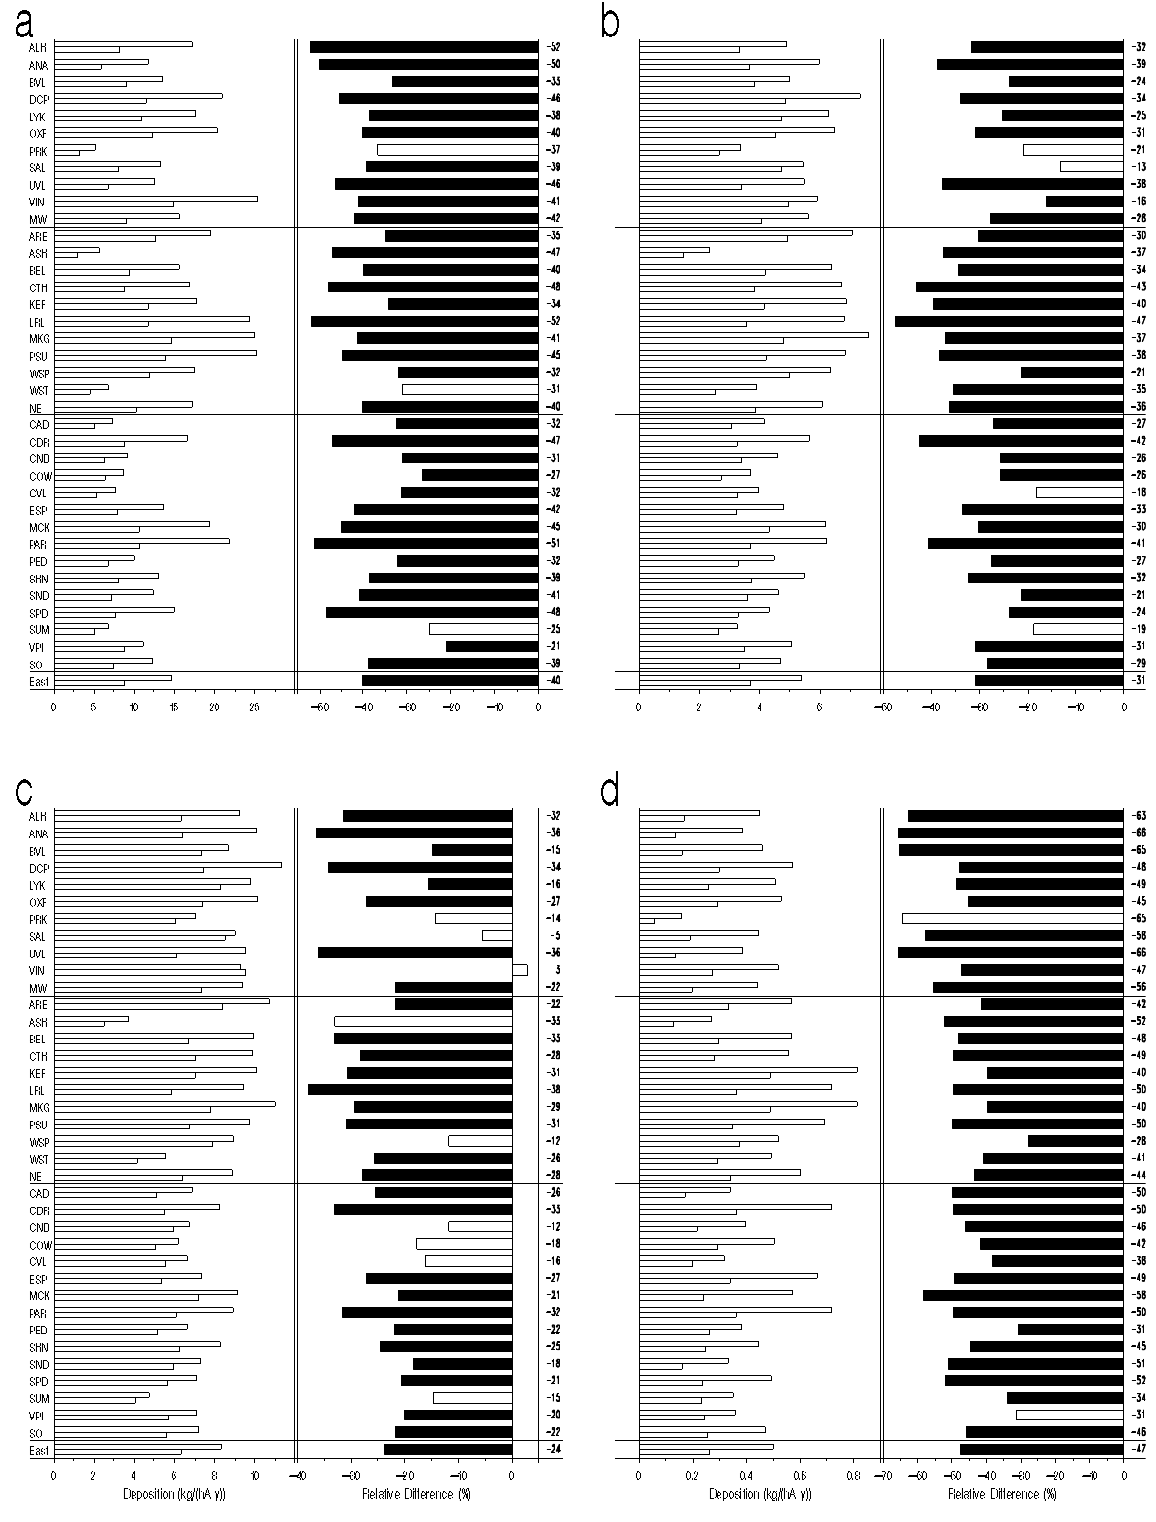
Figure 6. Site- and region-specific total deposition (kg ( ha yr ) − 1 , left – upper bar, P1; and lower bar, P4) and P1-to-P4 relative changes (%, right and bottom) for (a) Total S: total dry plus wet oxidized sulfur deposition; (b) Total OxN: sum of dry plus wet deposition of monitored oxidized nitrogen; (c) Total N: sum of total dry plus wet deposition of monitored oxidized plus reduced nitrogen; and (d) Wet H + : wet deposition of H + . Significance level of period-to-period relative changes indicated by bar fill: black, p ≤ 0 . 05; and open, p> 0 . 05 (NS). Sites are identified by region in the same order as shown in Table